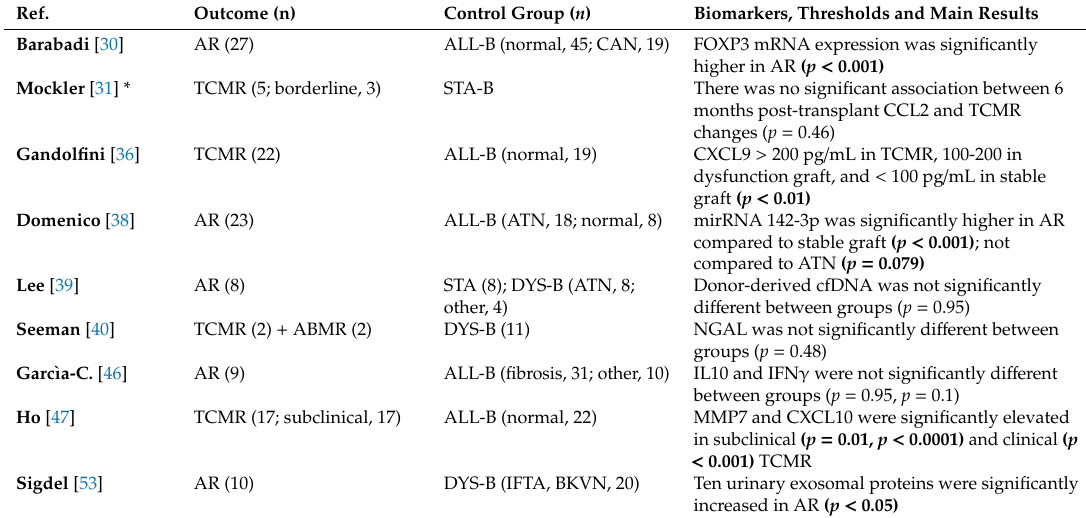
Table 6. Summary of the study results—Studies with no DTA. This table describes the main results from studies with no DTA. Sample size is reported for the outcome and control group when available. Ref. Biomarkers, Thresholds and Main